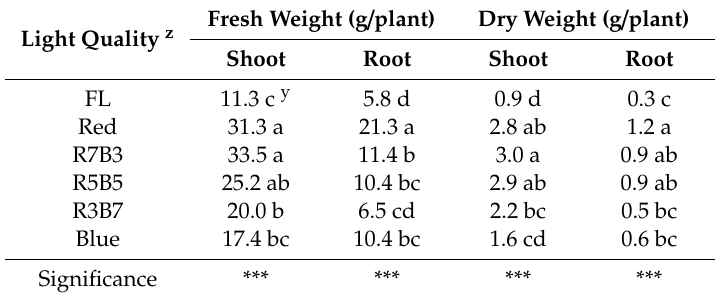
Table 1. Fresh and dry weights of shoots and roots of Salvia plebeia R. Br. as affected by different light treatments at 35 days after transplanting ( n = 3).